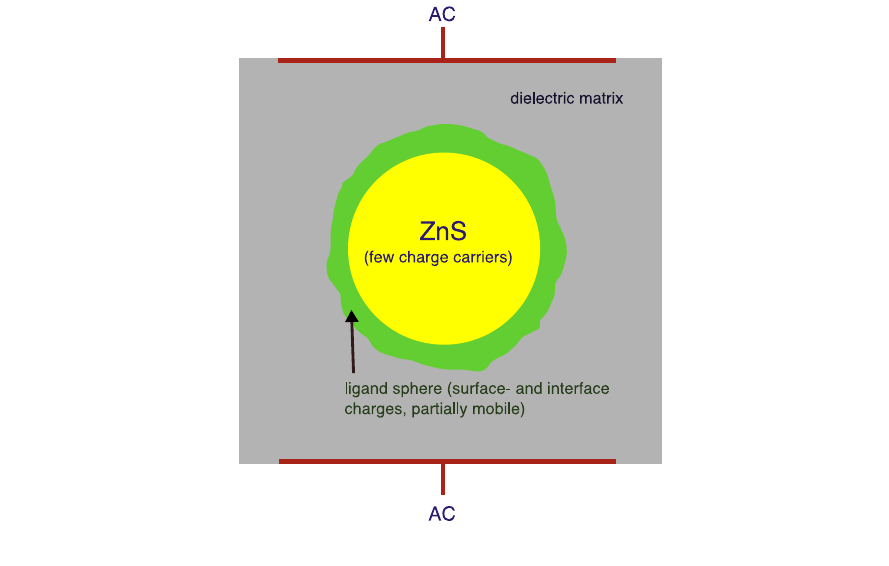
Figure 8 . Schmatic of the electrical conditions in a ligand-stabilized